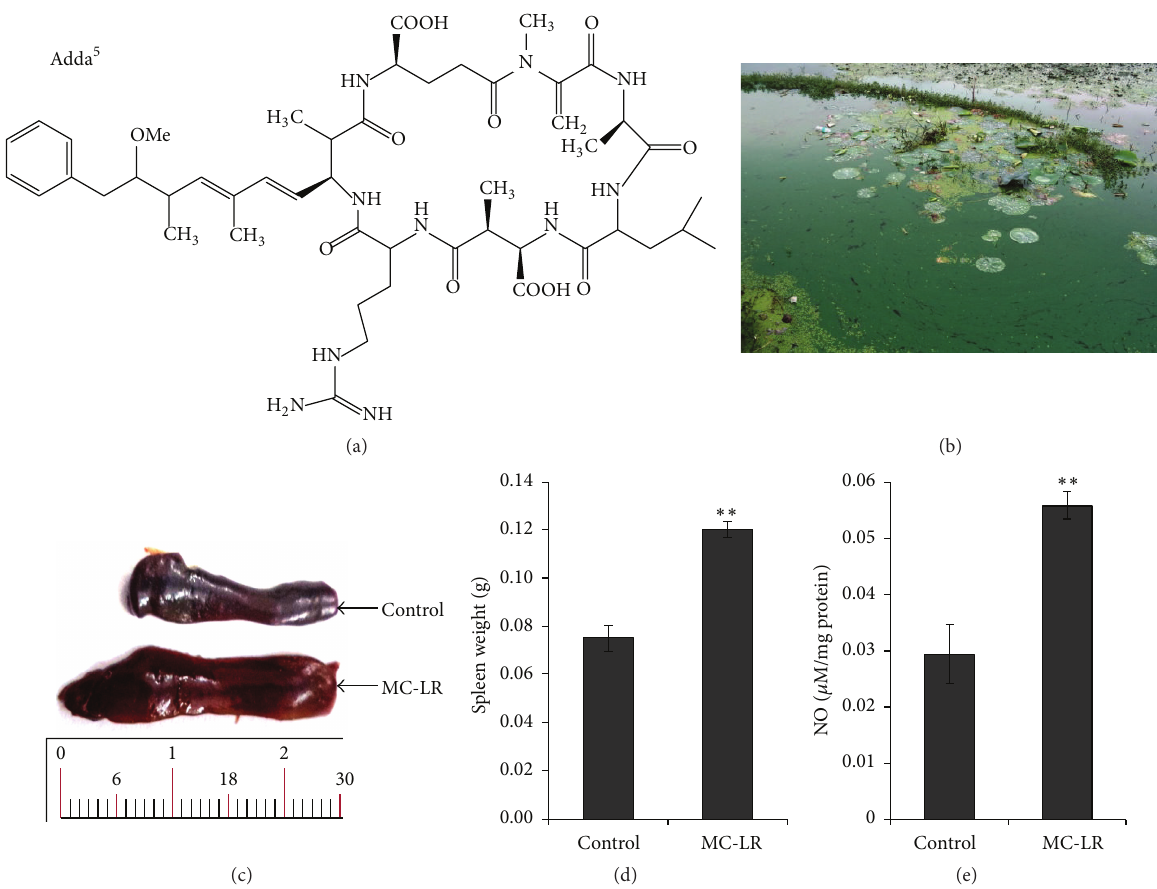
Figure 1: Structure of microcystin-LR (a) and Microcystis aeruginosa bloom in Sagar lake water (b) and MC-LR treatment of mice for 14 days shows splenomegaly (c) and causes a significant increase in the weight of spleen (d) and NO level in spleen (e). Values represent mean ± SD, where 𝑛 = 3 . ∗∗ 𝑝 < 0.01 (control versus MC-LR treated